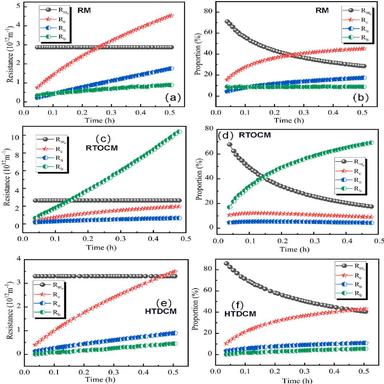
(a, c, and e) Temporal variations in the resistance components and (b, d, and f) percentages of resistance components in the total resistance of (a, b) RM, (c, d) RTOCM, and (e, f) HTDCM.